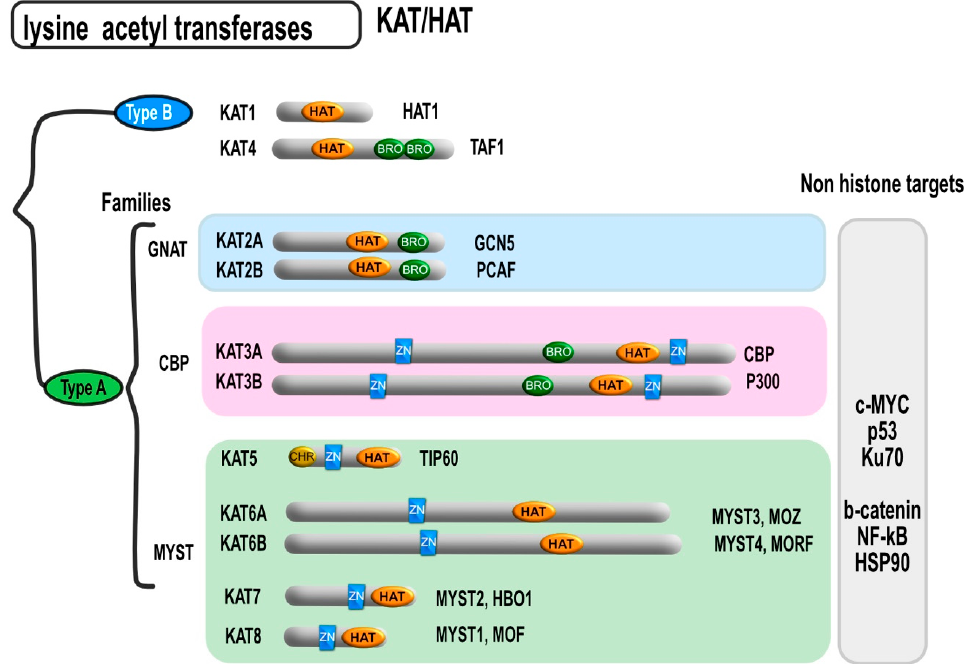
Figure 3. Different HAT/KAT subtypes and their domains. Besides the lysine